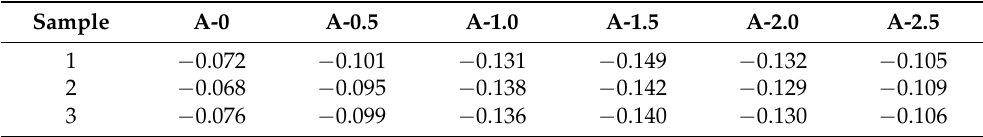
Table 4. Poisson’s ratios of different concave hexagonal cells.